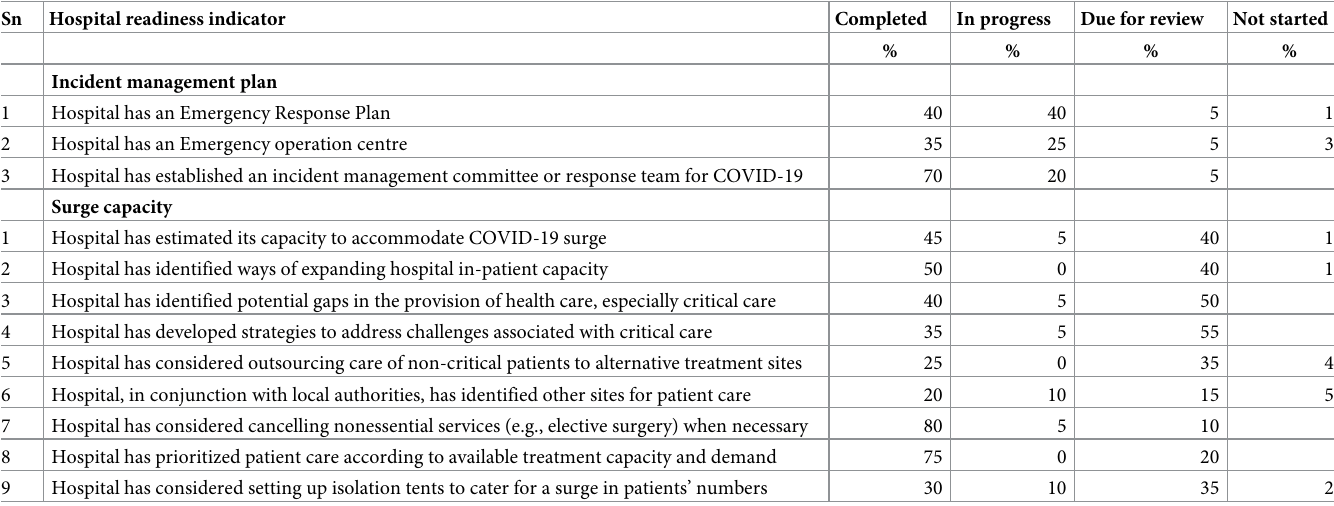
Table 3. Implementation of incident management plan and surge capacity readiness indicators among 20 hospitals in Nigeria.